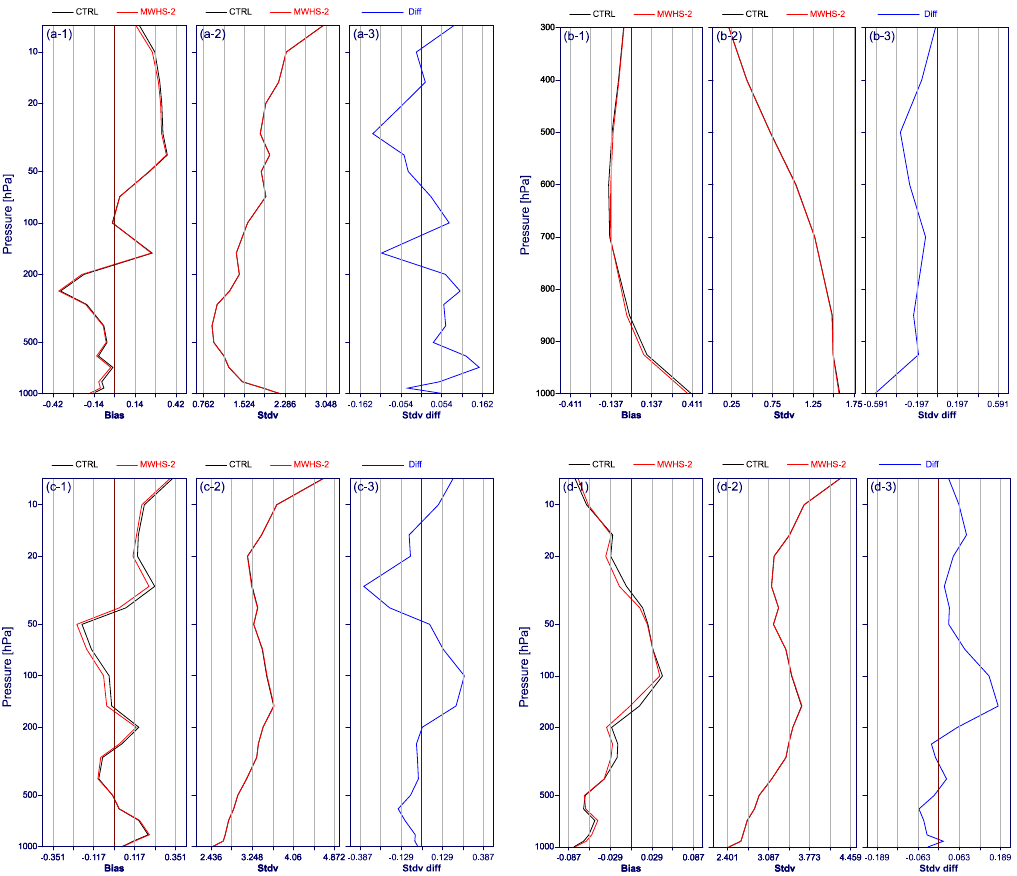
Figure 6. Mean, Stdv, and Stdv differences (left ‐ to ‐ right for each subplot) of radiosonde observed ( a ) temperature (K), ( b ) specific humidity (g/kg), ( c ) meridional wind (m/s), and ( d ) zonal wind (m/s) minus 6 ‐ h forecasts for the “CTRL” (black line) and “MWHS ‐ 2” (red line) experiments, averaged globally from August 1, 2016 to August 31, 2017. The Stdv differences (blue line) are calculated by 100 × (“MWHS-2” Stdv − “CTRL” Stdv) / (“CTRL” Stdv), indicating the percentage change of Stdv from assimilating MWHS-2 observations.